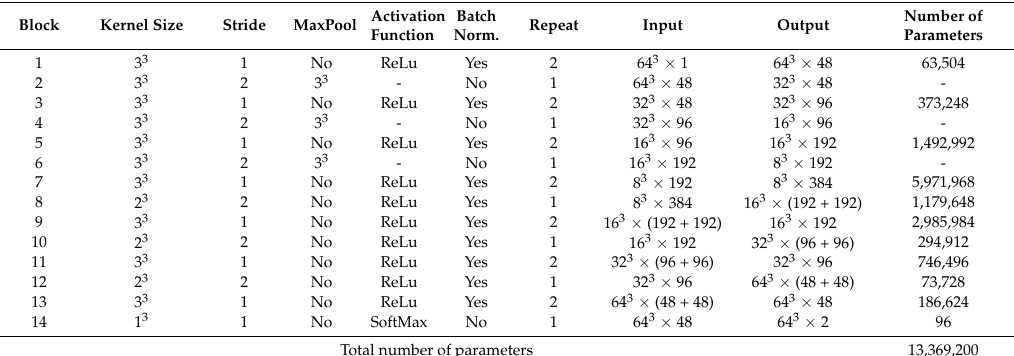
Table 1. 3D U-Net